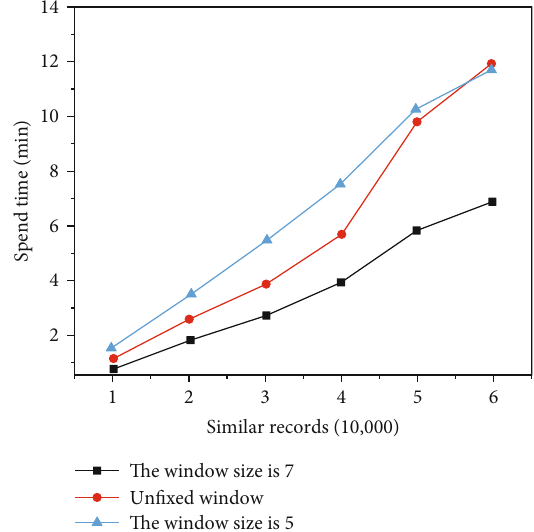
Figure 5: Elapsed time of di ff erent window sizes.